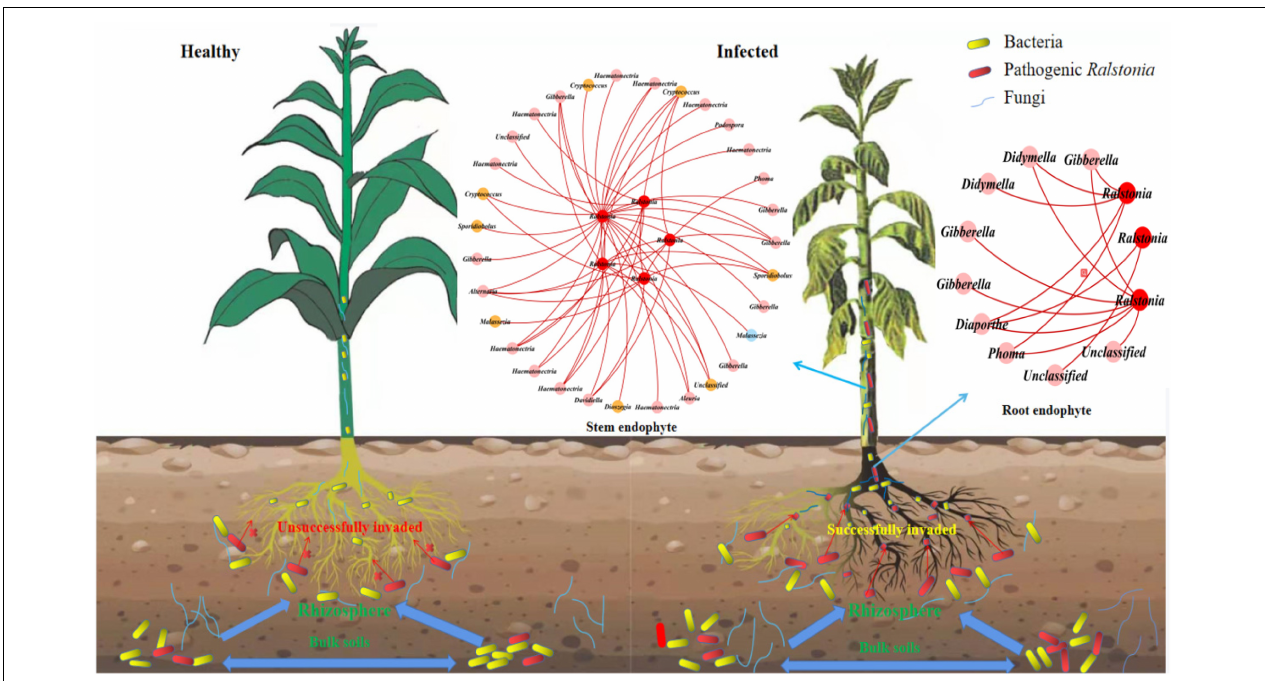
FIGURE 6 | Entangled webs of fungi-bacteria and fungi-pathogen associations in the microbial communities of the surrounding soil, rhizosphere, and root and stem endophytic compartments. The healthy plant (left) successfully suppressed invasion of pathogenic Ralstonia . The infected (right) plant was successfully invaded by the pathogen. The Interdomain ecological networks of the associations between pathogenic bacteria (red) and other fungal species in the root and stem endophytic compartments of the infected samples. Each node is marked at the genus level. Red links indicate negative